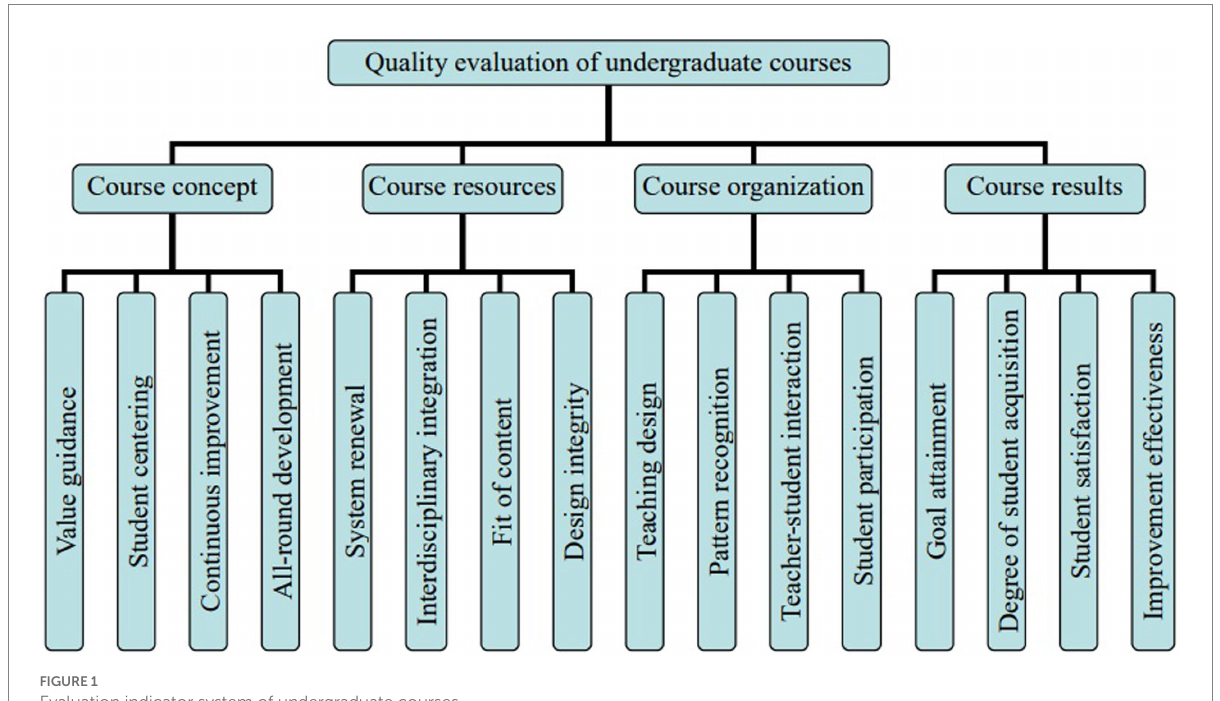
FIGURE 1 Evaluation indicator system of undergraduate courses.